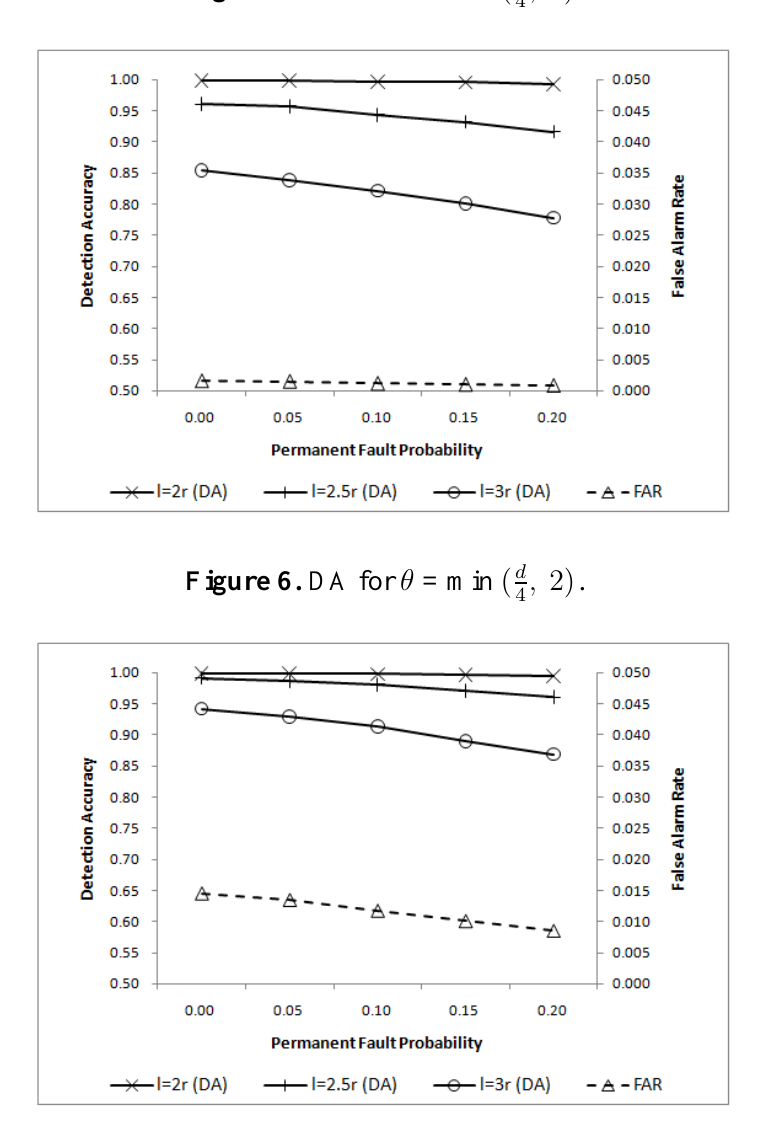
Figure 5. DA for θ = min ( d